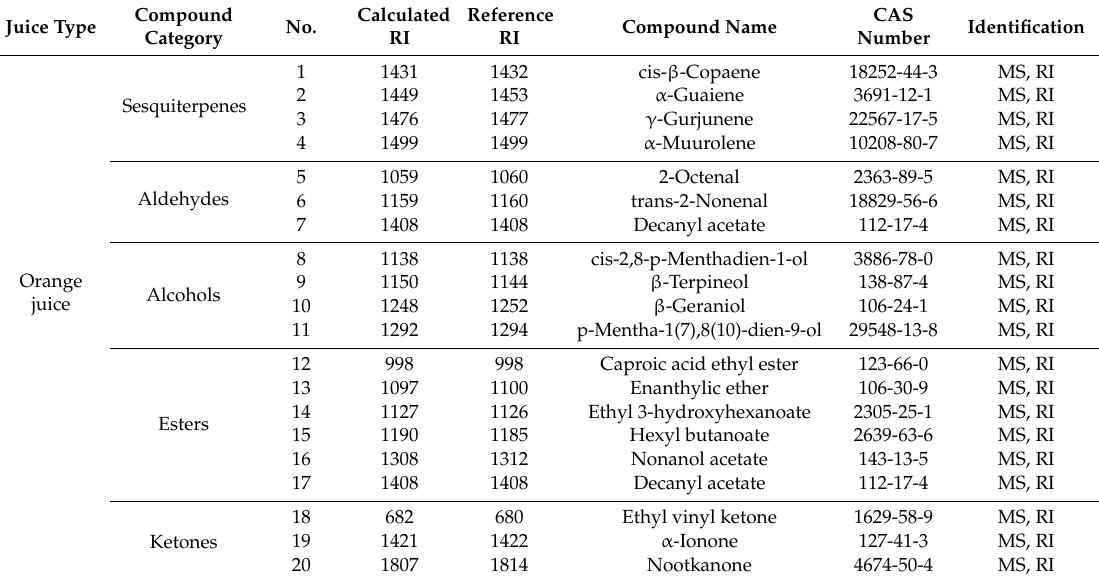
Table 1. Characteristic volatile organic compounds identified in sweet orange juices and mandarin juices.